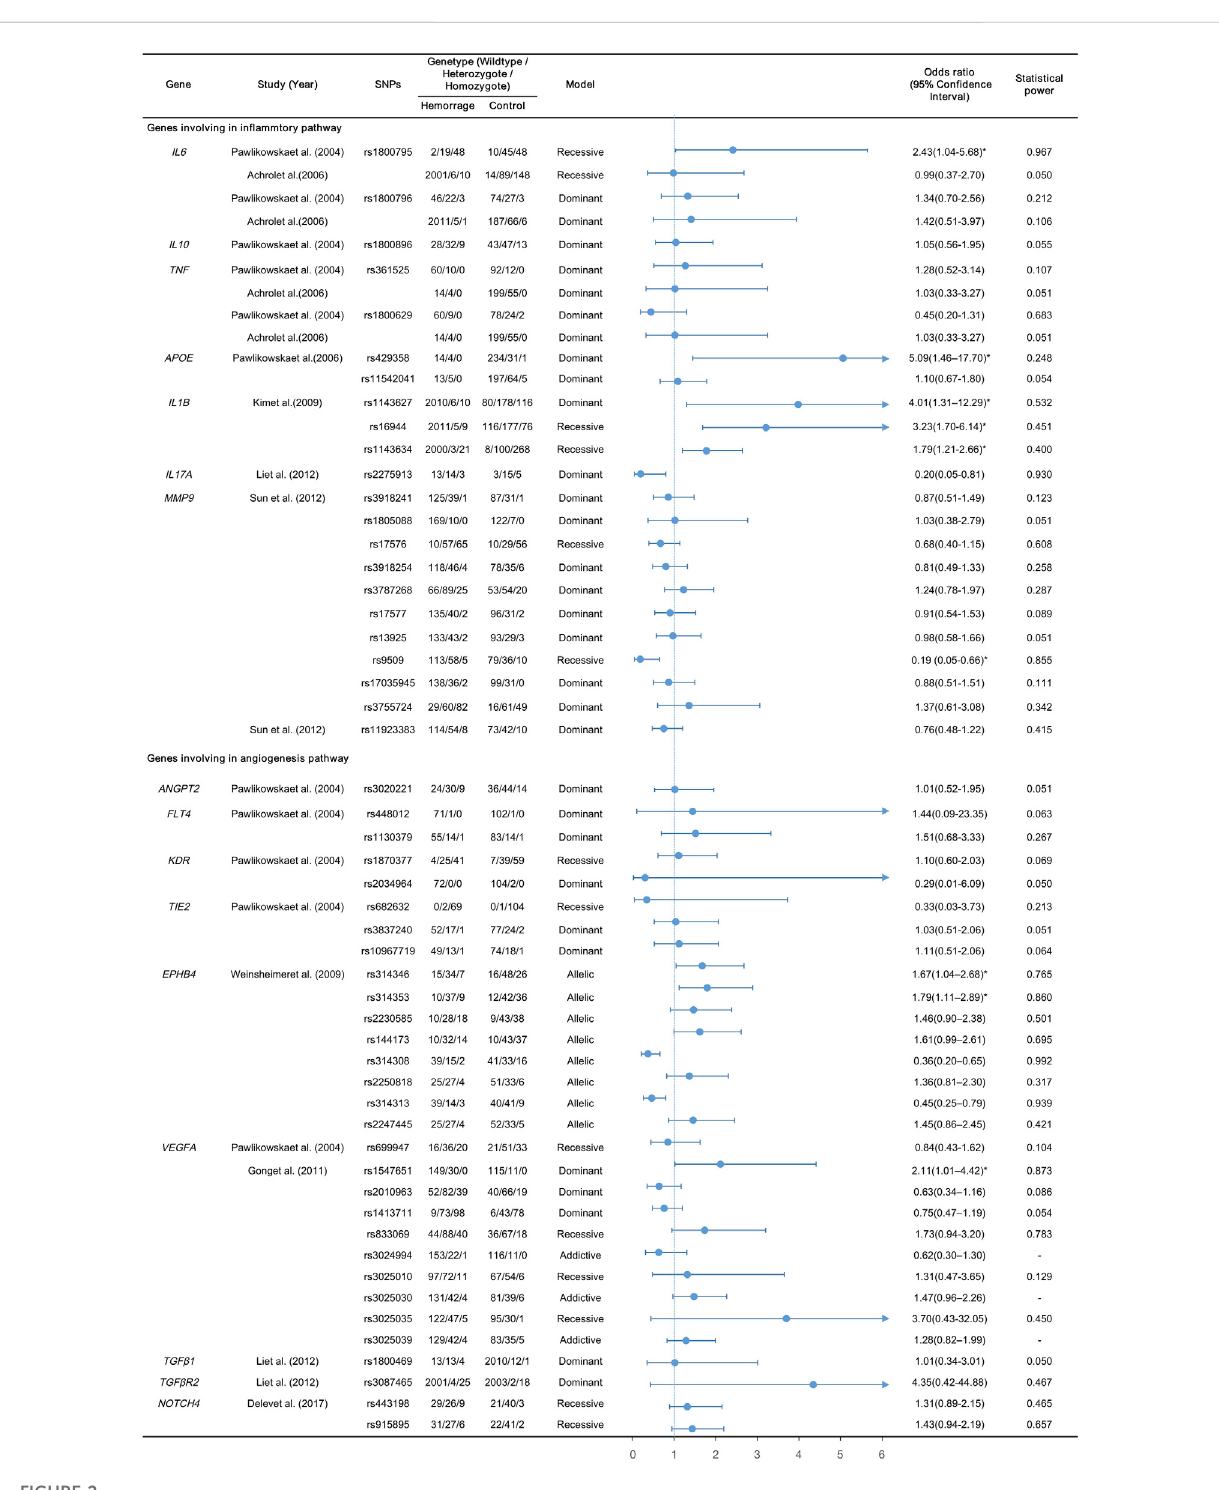
FIGURE 2 Summary and forest plots for the reported variants; *, calculated by multivariant